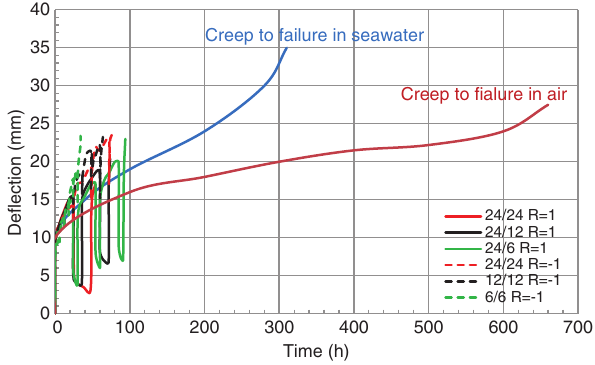
Figure 2: Typical cyclic R = 1 and R = -1 test results compared with creep to failure tests performed in seawater and air.